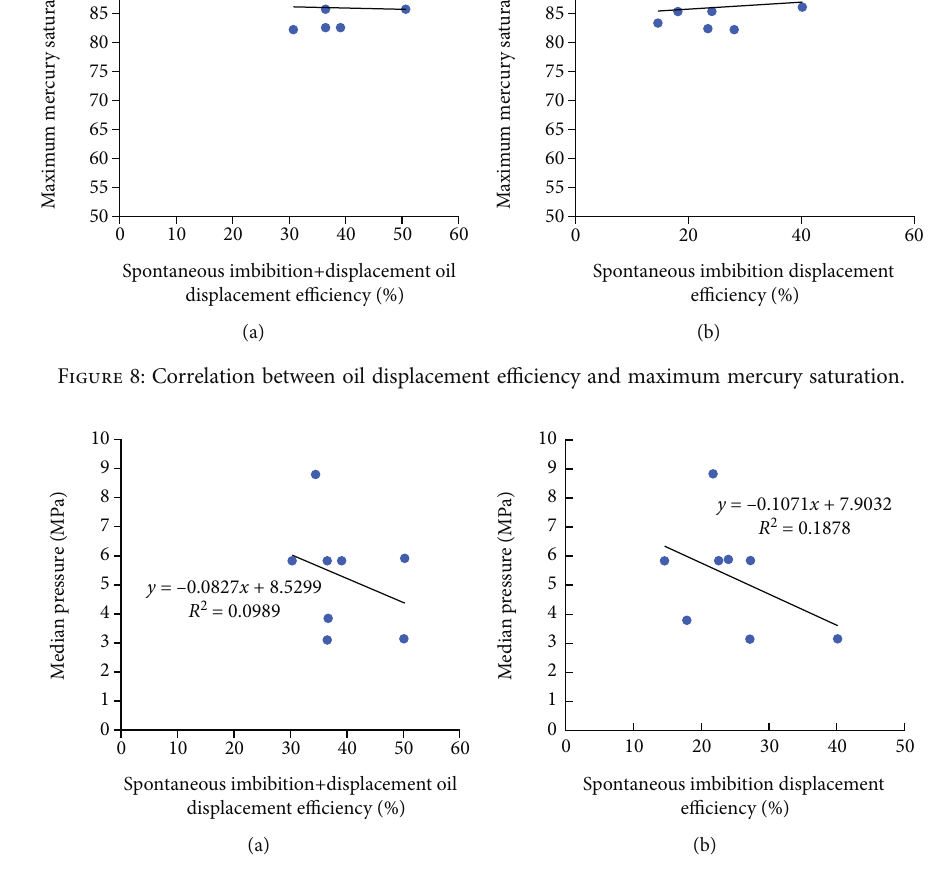
Figure 9: Correlation between oil displacement e ffi ciency and median e ffi ciency. The greater the in fl uence of displacement speed 3.3. Displacement Speed. Figure 11 shows the relationship on oil displacement e ffi ciency, the better. It is necessary to between di ff erent displacement rates and the fi nal oil recov- comprehensively consider physical parameters, pore charac- ery e ffi ciency. It can be seen that there is no obvious correla- teristics, media types, and other factors. tion between displacement speed and oil displacement